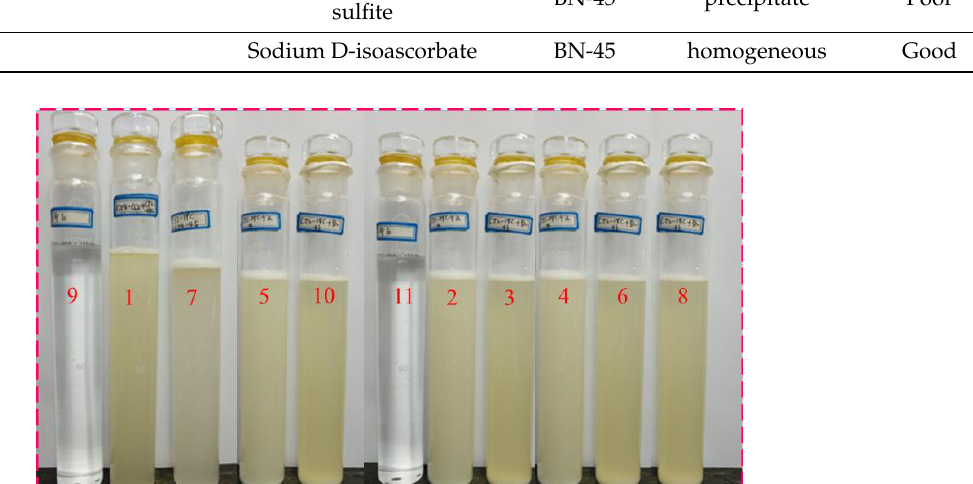
Figure 13. Compatibility test between various additives and formation water diluted with different proportions of clear water.